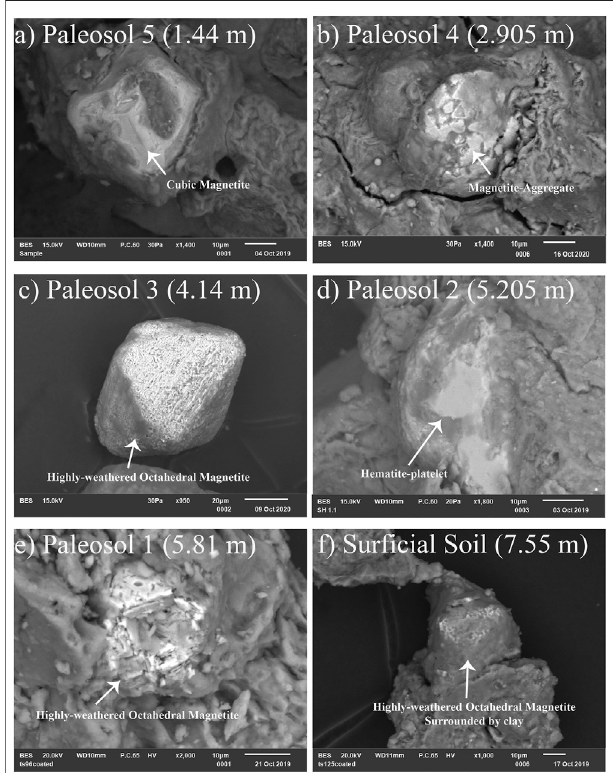
FIGURE 4 | Scanning electron microscopy (SEM) images of Blackwater Draw sediment images a-f respectively represent specimens from Paleosols 5-Sur fi cial Soil. ( A ) Paleosol 5: Cubic shaped magnetite grain surrounded by clay, note the general absence of shrinkage cracks. ( B ) Paleosol 4: Aggregation, of magnetite particles, the triangular faces are interpreted to represent octahedral faces. ( C , E , F ) Paleosol 3,1, and Sur fi cial Soil respectively: Heavily weathered magnetite grains, the shattered appearance ofthe grain isinterpreted torepresent anoverabundance ofshrinkage cracks, which in turn suggest low-temperature oxidation (Johnson and Merrill, 1973; Petersen and Vali, 1987; Cui et al., 1994; Zhou et al., 2001; Vahle et al., 2007; Gehring et al., 2009; Nowaczyk, 2011; Haltia and Nowaczyk, 2014). ( D ) Paleosol2:Hematite platelet,ingeneraltheSEMwasonlyabletodetectafew examples of hematite in the specimens (Supplementary Files C_I – C_VI); this suggests that the majority of hematite content is likely submicron in scale.